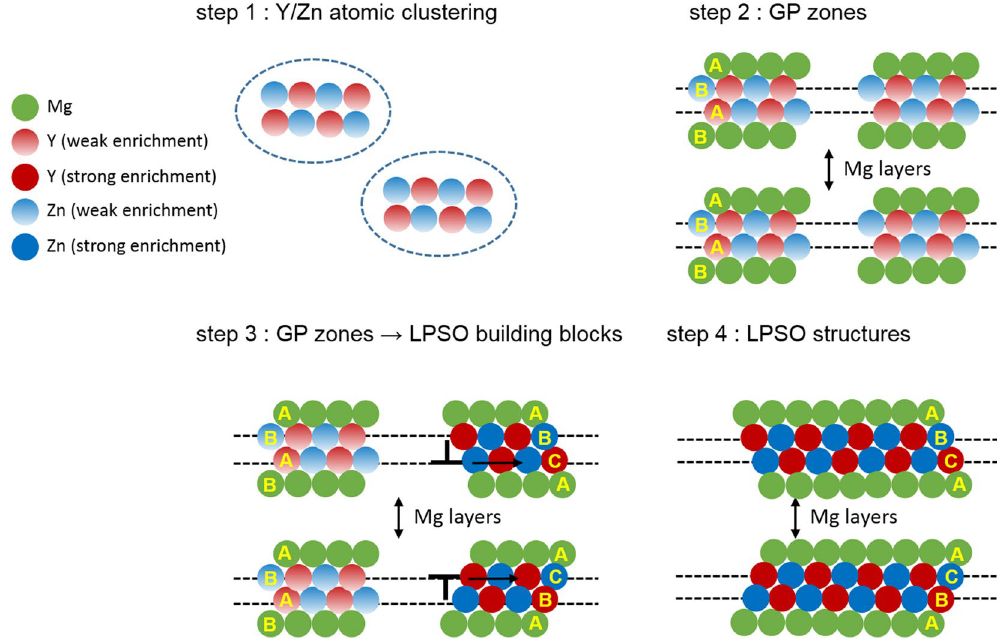
Figure 5. Sequential diffusional-displacive transformation mechanism. Y/Zn atomic clusters are expected to form first in the super-saturated Mg matrix (step 1) followed by the formation of Y/Zn enriched GP zones on the basal planes of the Mg matrix (step 2). Above a critical amount of Y and Zn atoms in the GP zones, LPSO building blocks are formed from the GP zones by the generation and propagation of Shockley partial dislocations (step 3). LPSO structures can be formed during annealing (step